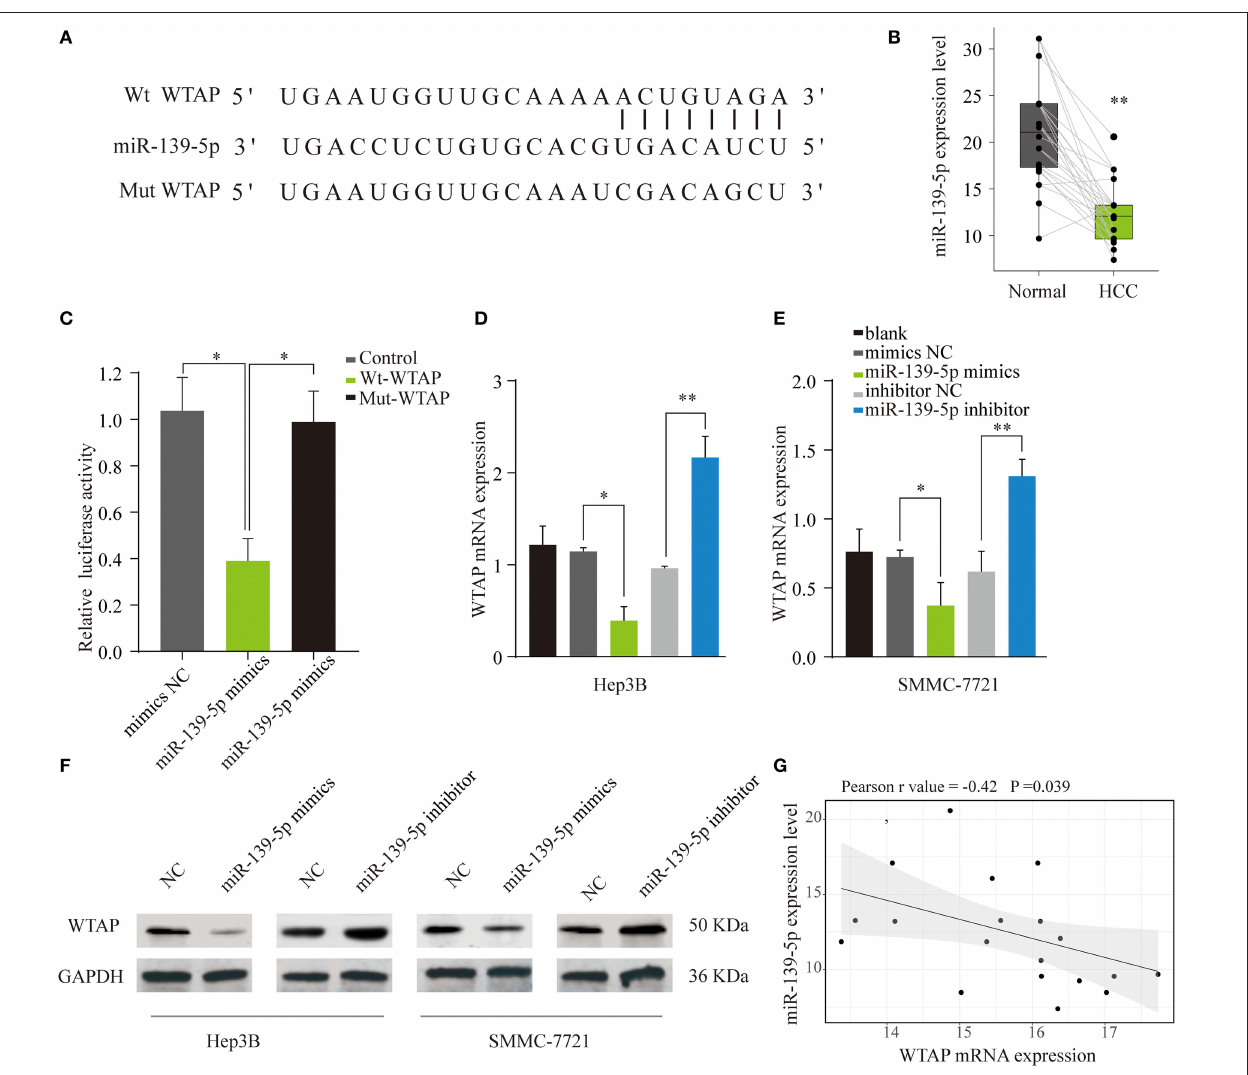
FIGURE 6 | WTAP is a direct binding target of miR-139-5p. (A) Predicted target site of miR-139-5p on the 3 ′ untranslated region (3’-UTR) of WTAP and the mutated WTAP 3 ′ -UTR sequences. (B) Quantification of the miR-139-5p expression levels in HCC and normal tissues through quantitative PCR (qPCR) ( n = 22). (C) HEK293 cells were transfected with a reporter vector containing wild type (wt) or mutant (mut) 3 ′ -UTR of WTAP, together with miR-139-5p mimics or negative control. The relative luciferase activity was assessed for 48h later. The mRNA (D,E) and protein (F) levels of WTAP in Hep3B or SMMC-7721 cells transfected with miR-139-5p mimics, inhibitor, and negative control were analyzed by qPCR and western blot. (G) Pearson correlation analysis of the relationship between the WTAP expression and miR-139-5p expression in HCC tissues. * p < 0.05, ** p <